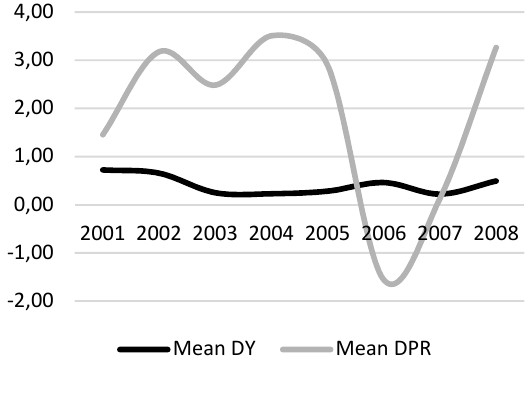
Figure 2. Development of Average. Average Value Indicator policy Sector Dividend Property and Real Estate during